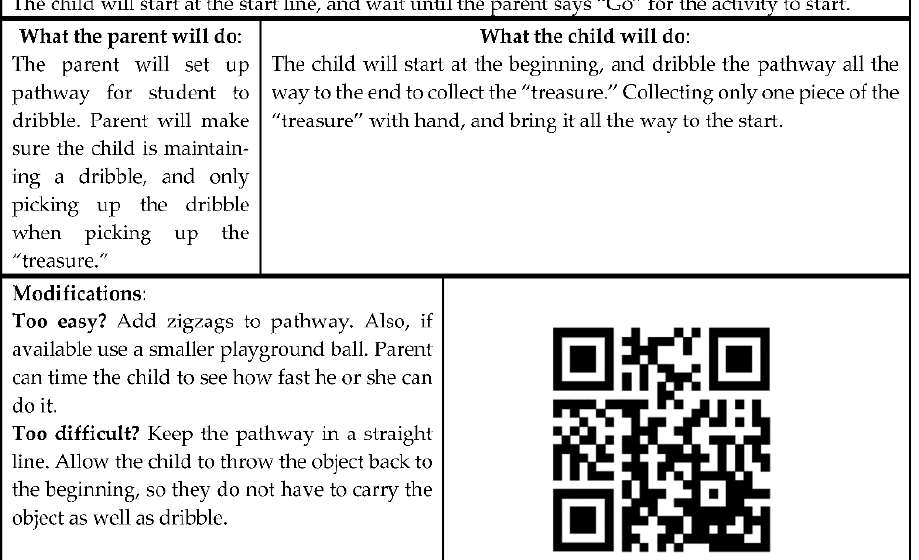
Figure 2. Example of one of the games included in the activity booklets.